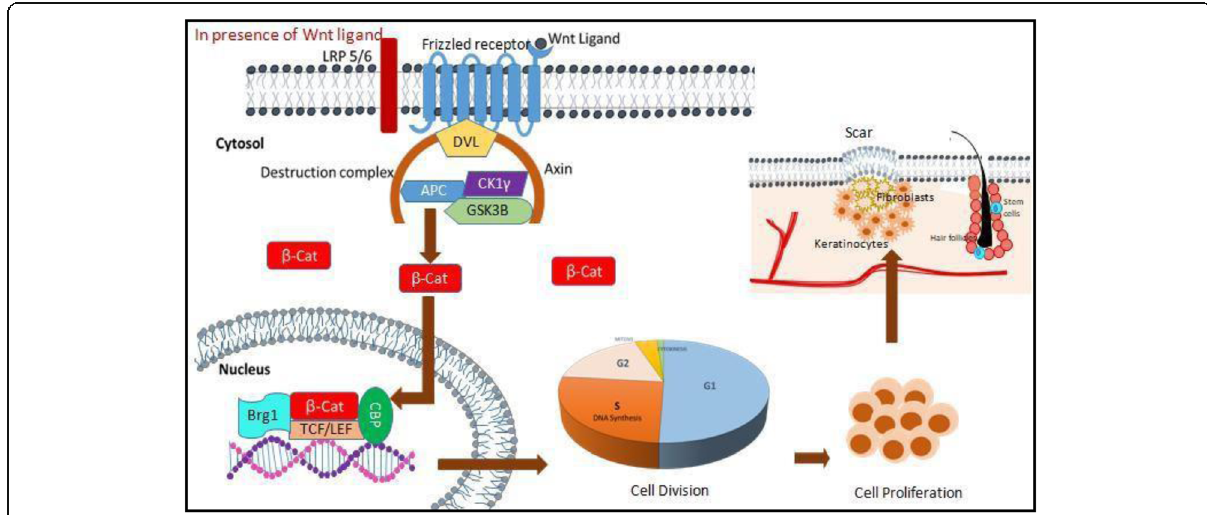
Fig. 2 Wnt proteins bind to Frizzled (Fz) and LRP-5, Axin is recruited to the membranes. The interaction between Axin and LRP-5 may prevent Axin from participating in the degradation of β -catenin. Dvl may also receive signals from the Fz/LRP complex, resulting in the inhibition of GSK3B. β -catenin is not degraded, which eventually leads to transcription of the Wnt-targeted gene, which results in the following events like cell division, cell proliferation, and cell migration to the wound